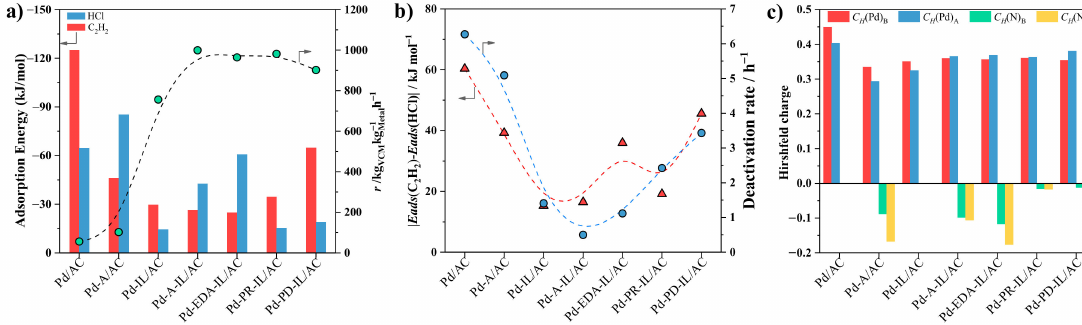
Figure 6. ( a ) Rate of VCM formation versus the adsorption energy of acetylene and hydrogen chloride for investigated catalysts. ( b ) Deactivation rate versus | E ads (C 2 H 2 )-E ads (HCl) | for investigated catalysts. ( c ) Hirshfeld charge of Pd atoms (C H (Pd)) and N atoms (C H (N), where N is from N-containing ligands) before (C H (Pd) B , C H (N) B ) and after (C H (Pd) A , C H (N) A ) acetylene